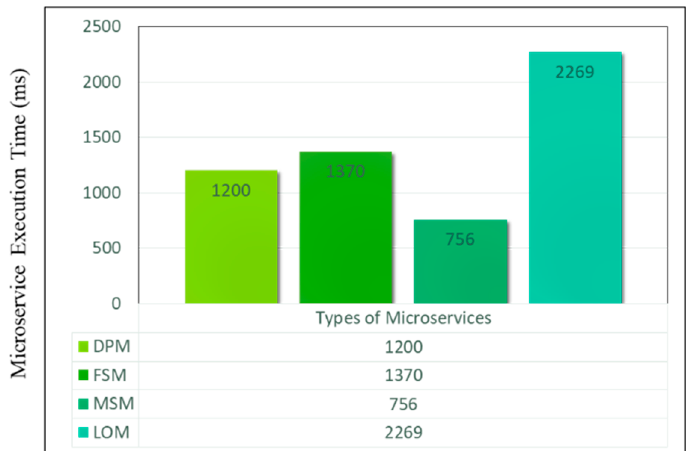
Figure 20. Execution time for four microservices.